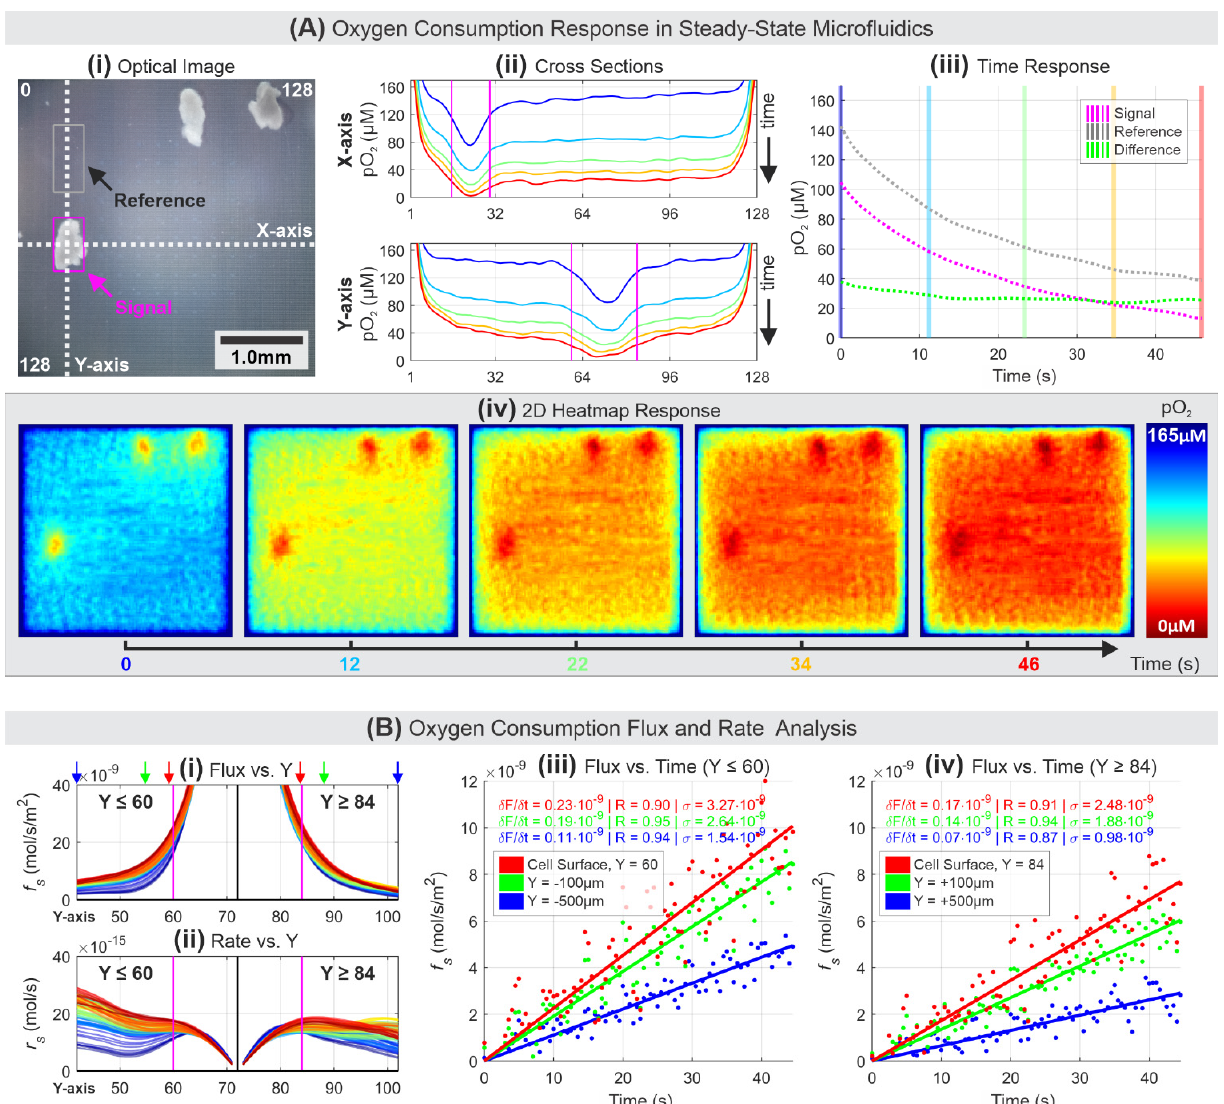
Figure 7. ( A ) Oxygen gradient imaging in static media of a healthy COC. ( B ) (i,ii) Analysis of oxygen consumption flux and rate based on the Y-axis cross-section at multiple distances over a period. Flux scatter plots in (iii,iv) correspond to Y locations at the surface of COC, 100 µm, and 500 µm away to either side of the COC, with each Y location pointed by arrows in (i).